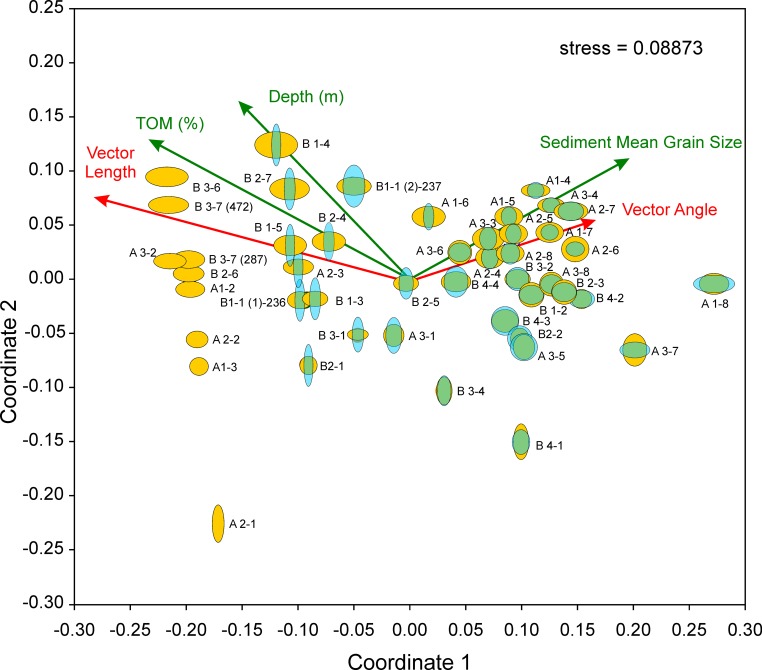
Diversity diagrams of sample sites positioned in a coordinate system obtained by nMDS.Influence of environmental factors water depth, SMGS and TOM represented as vectors together with the variables standardized diversity vector’s length and angle. Living assemblages in light blue and dead assemblages in orange.